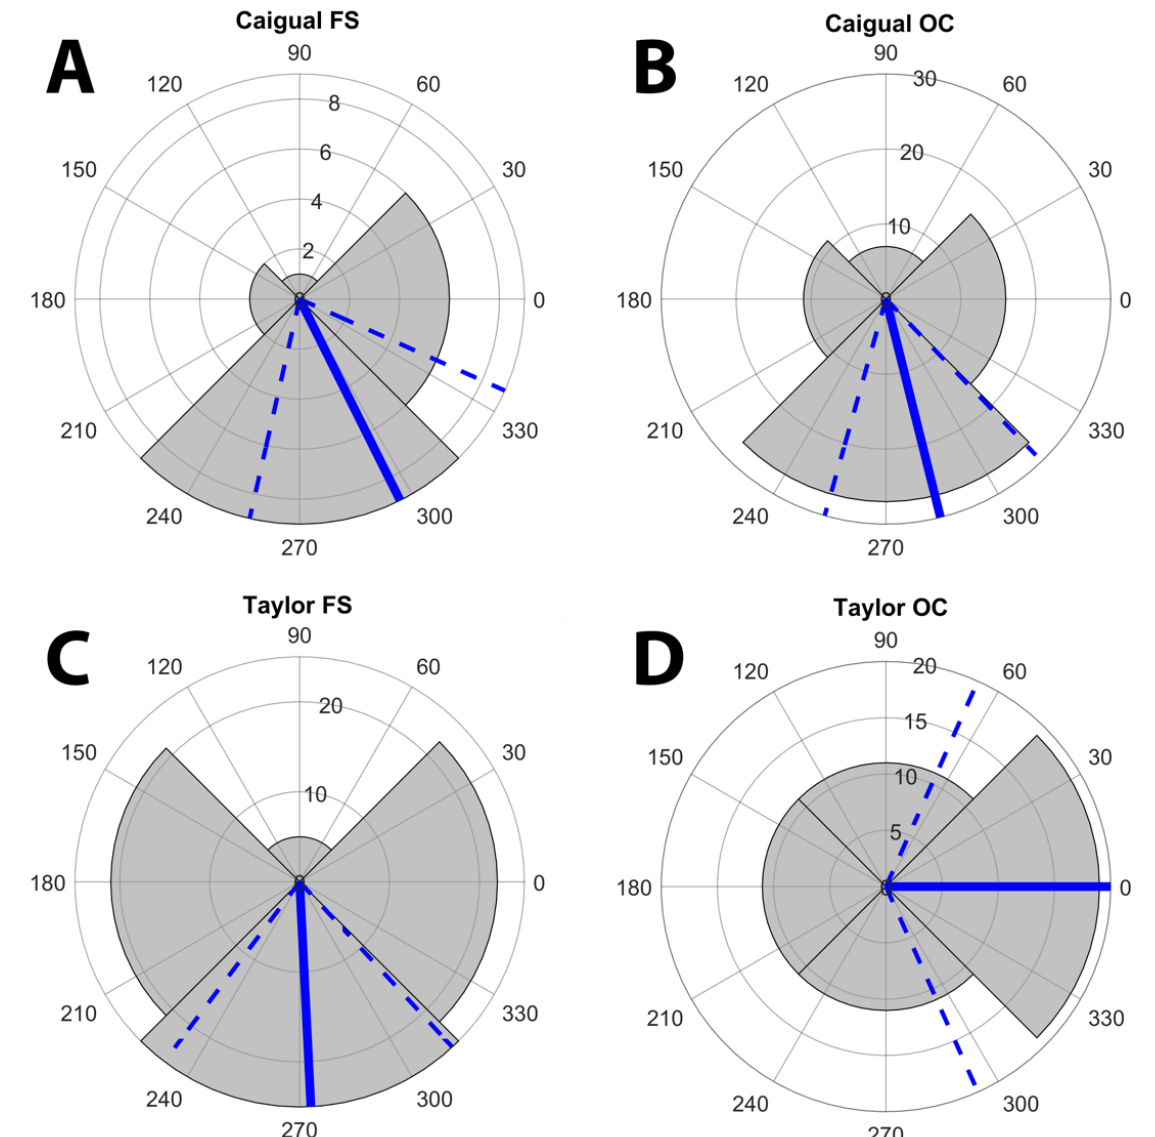
Figure 5. Direction data separated by both stream and light environment: FS (forest shade) and OC (cloudy). Symbolism as in Figure 2. The was no significant difference between FS and OC in Caigual, but there was a significant difference in Taylor. Test results: ( A ) Caigual FS mn = 296.6°, s0 = 18.57, p = 0.022, n = 18. ( B ) Caigual OC mn = 284.0°, s0 = 14.55, p = 0.0000, n = 61. ( C ) Taylor FS mn = 272.9°, s0 = 18.76, p = 0.0000, n = 73. ( D ) Taylor OC mn = 0.0°, s0 = 33.59, p = 0.0012, n = 52.